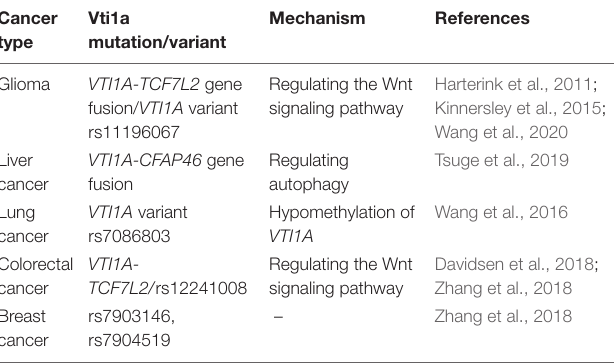
TABLE 2 | The mutation/variant of Vti1a in different